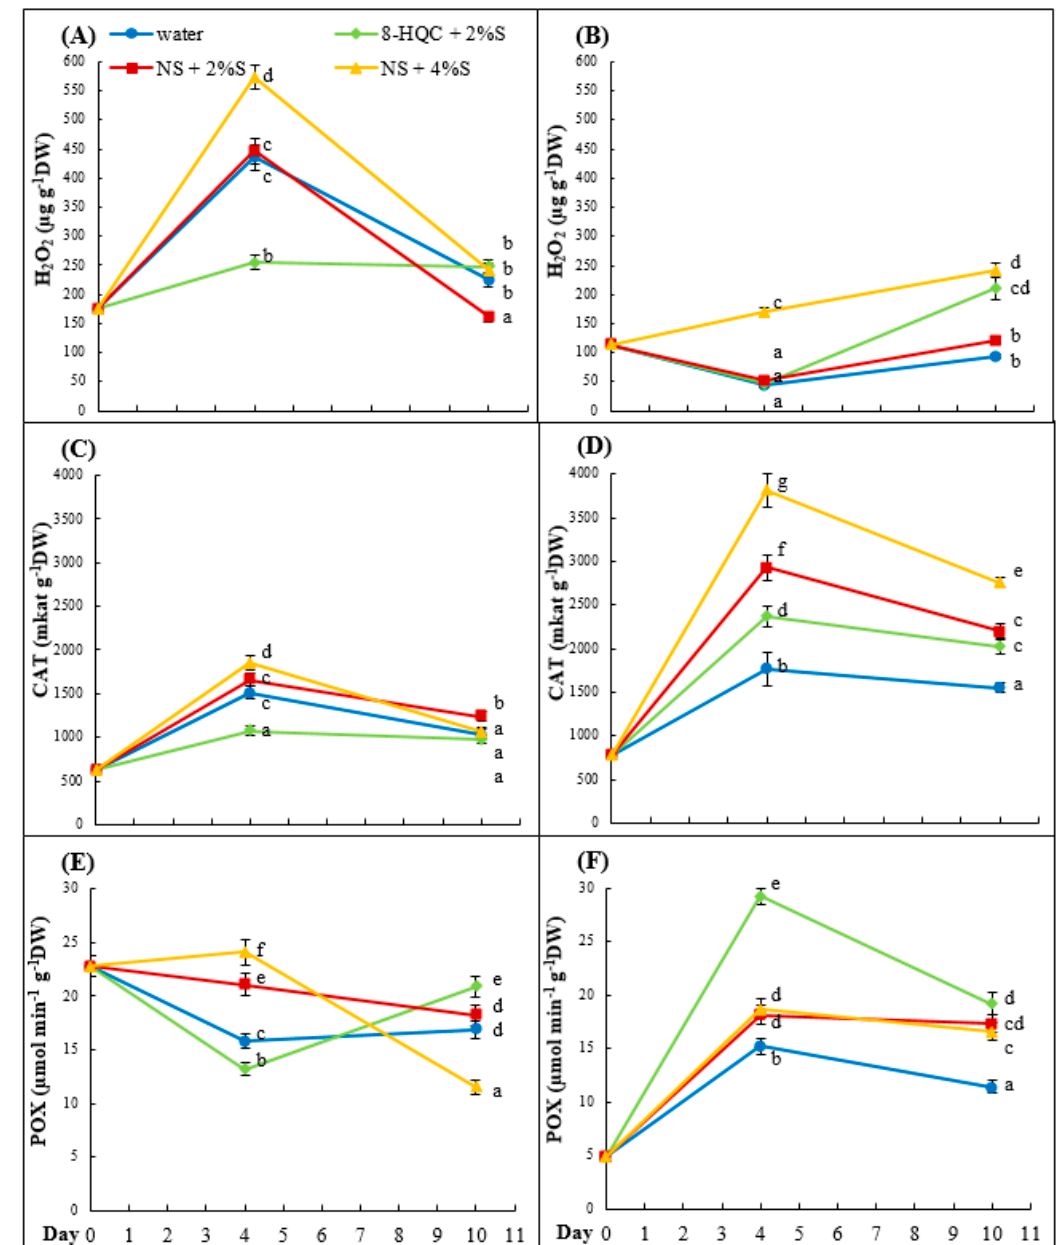
Figure 5. Hydrogen peroxide (H 2 O 2 ) content ( A , B ), CAT activity ( C , D ) and POX activity ( E , F ) in cut non-stored peony flowers ( A , C , E ) and in cut peony flowers after 12 weeks storage ( B , D , F ) during 10 days of vase life. Value are expressed as means ± SD of triplicate assays. Vertical bars represent standard deviations of the means. Means followed by the same lower case letter do not differ significantly at α = 0.05 (Duncan’s test). Analyses were done separately for non-stored and stored flowers.